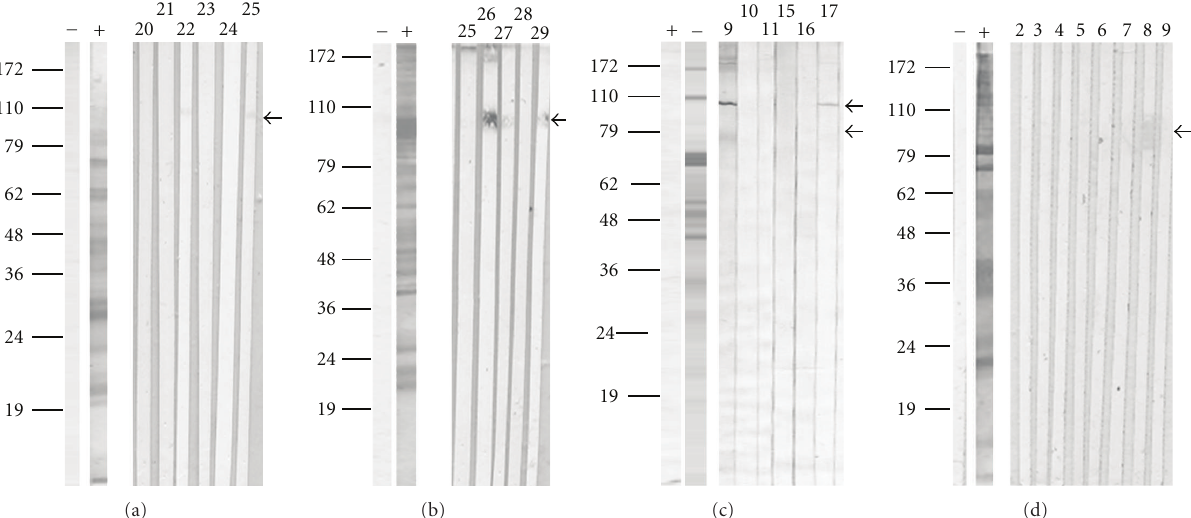
Figure 6: Western blot shows cross-reaction with other helminthes. Crude extracts (CE) from (a) Taenia saginata , (b) Taenia taeniaeformis , (c) Hymenolepis diminuta , and (d) Ascaris lumbricoides were confronted with 33 hamster sera infected with T. solium tapeworms. Hyperimmune sera prepared in rabbits against each of the CE were used as positive controls (lanes +) and preimmune sera from rabbit were used as negative controls (lanes − ). WB shows representative samples of the assay. Number of lanes is corresponding to serum number of the